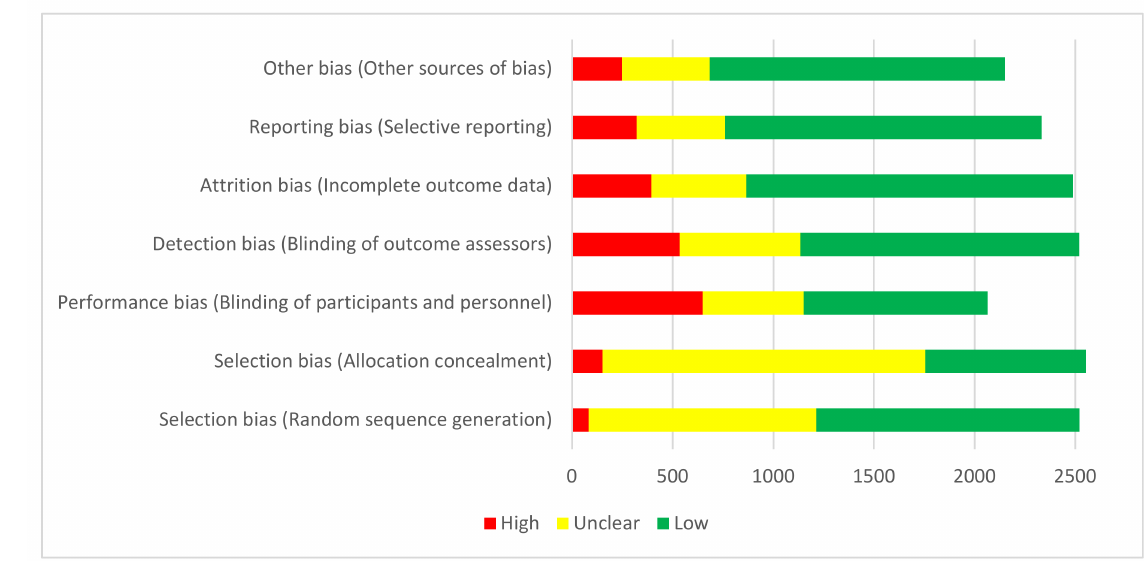
Figure 3. Risk of Bias assessment for all domains of RCTs included and assessed in Cochrane Oral Health systematic reviews.